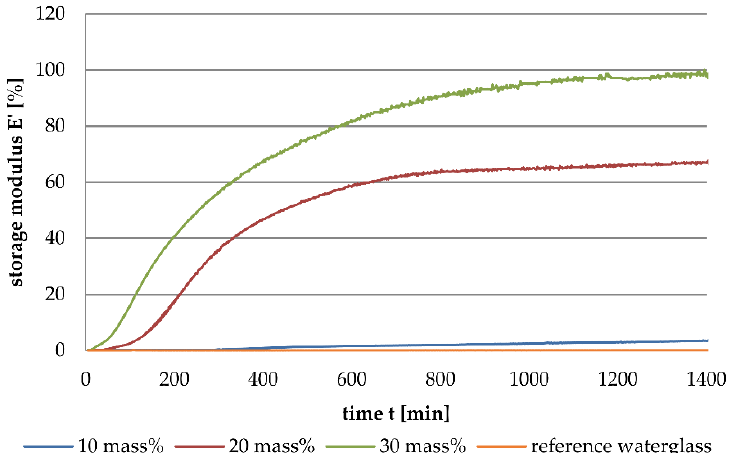
Figure 1. DMA measurements of the waterglass samples with different added content of AlPO 4 hardener at T A = 25 °C. The reference is a waterglass sample without any hardener added.